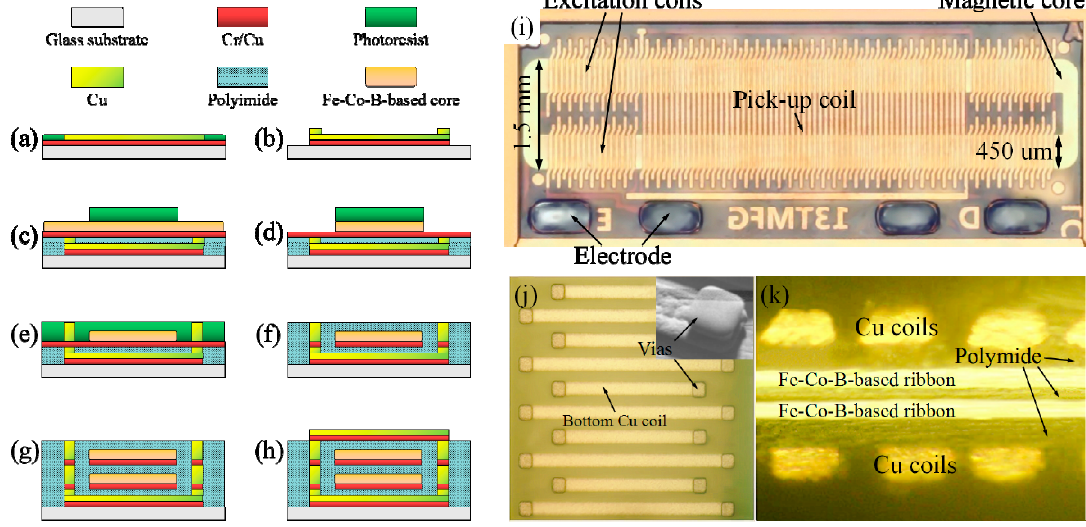
Figure 2. ( a – h ) The detailed fabrication process of the micro-fluxgate sensor; ( i ) the fabricated micro-fluxgate sensor; ( j ) images of the bottom coil and vias; ( k ) the cross-sectional image of the sensor.